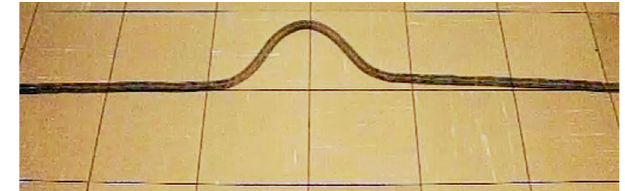
FIG. 4. The students watching the slow motion video of the initial observational experiment will notice that when the pulses overlap the amplitude is about twice as large as the amplitude of individual pulse before they met (compare with Fig. 1).